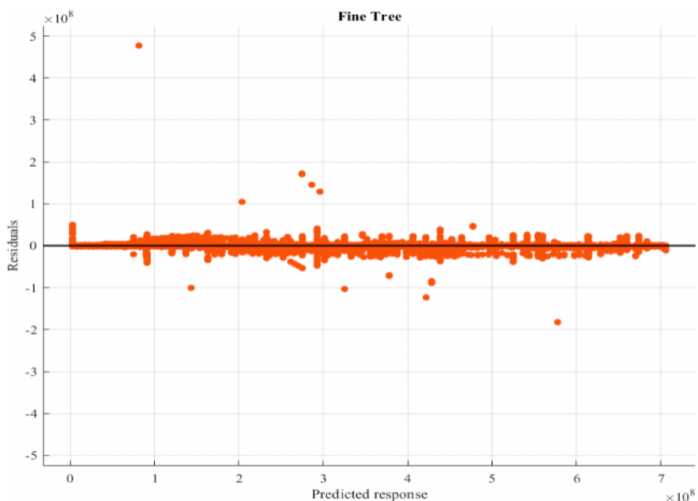
Figure 12. Fine Trees Residual testing.